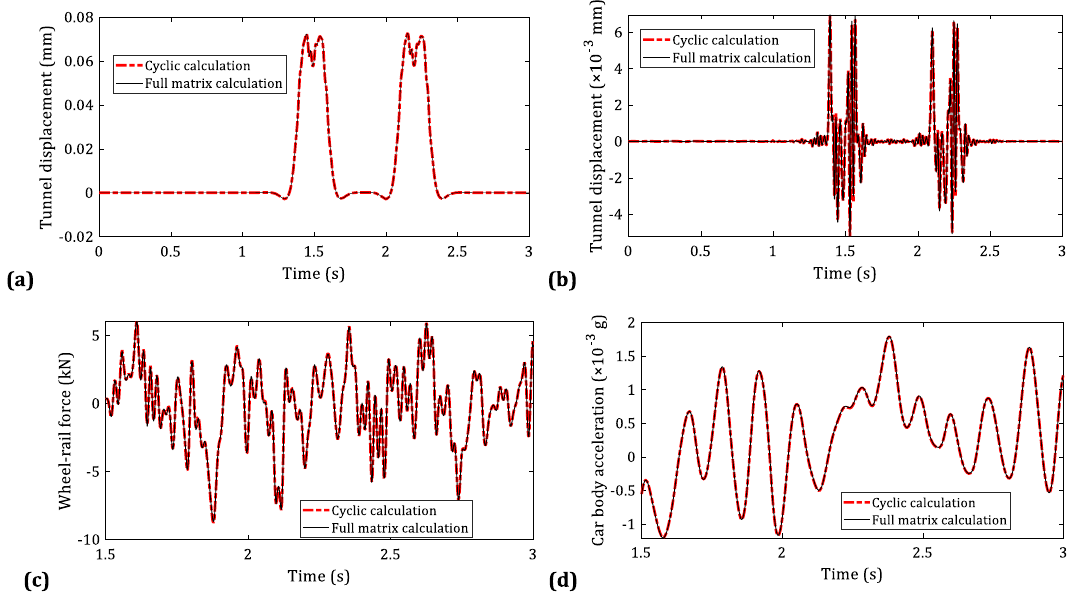
Fig. 7 Comparisons between cyclic calculation and full matrix calculation: a tunnel vertical displacement; b tunnel lateral displacement; c wheel-rail lateral force; d car body lateral